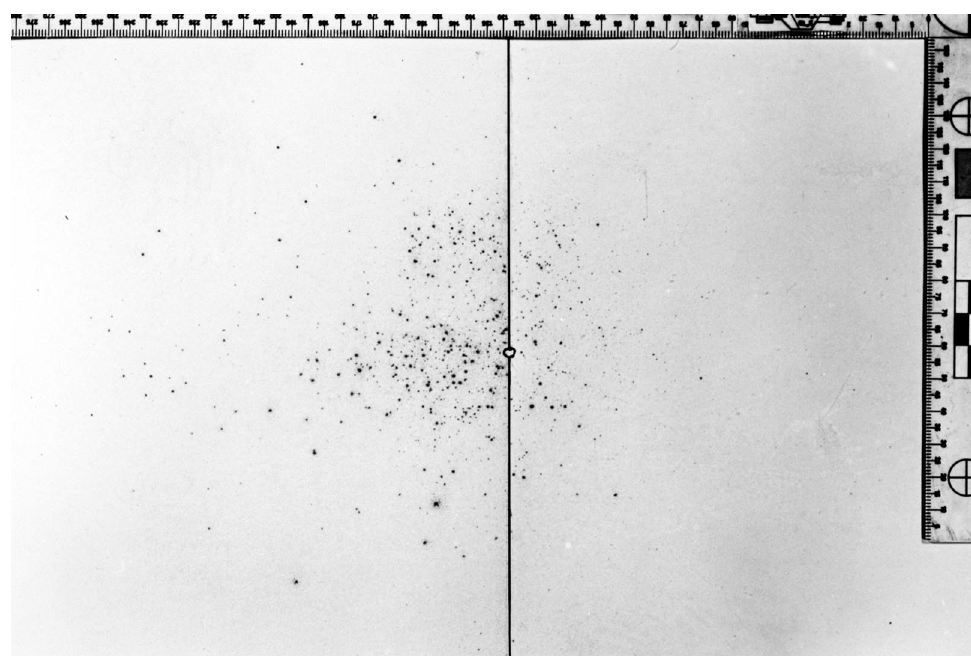
FIGURE 3 . The effect of brushing on the total nitrite visualization on a white polyester cloth. Same ammunition and distance as in Fig. 2. Black and white photograph of the target: (left) the target without